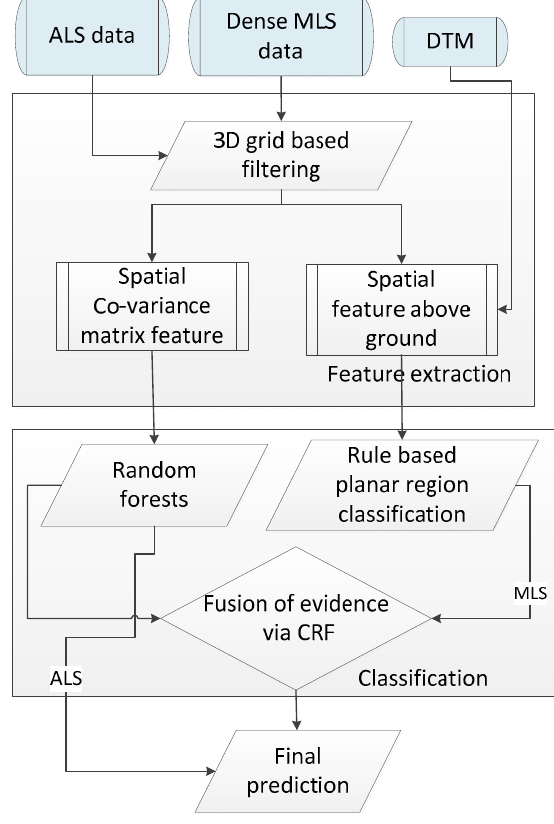
Figure 2. Workflow for semantic labeling of point clouds.